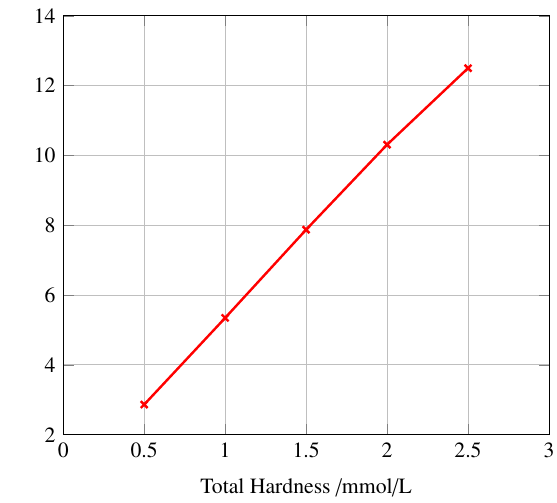
Figure 5. Dependence of the conductance on total hardness of wa- ter.